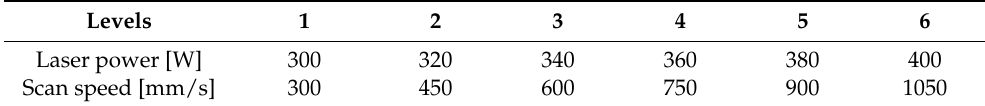
Table 2. Process parameters for the single-track experiments. Levels